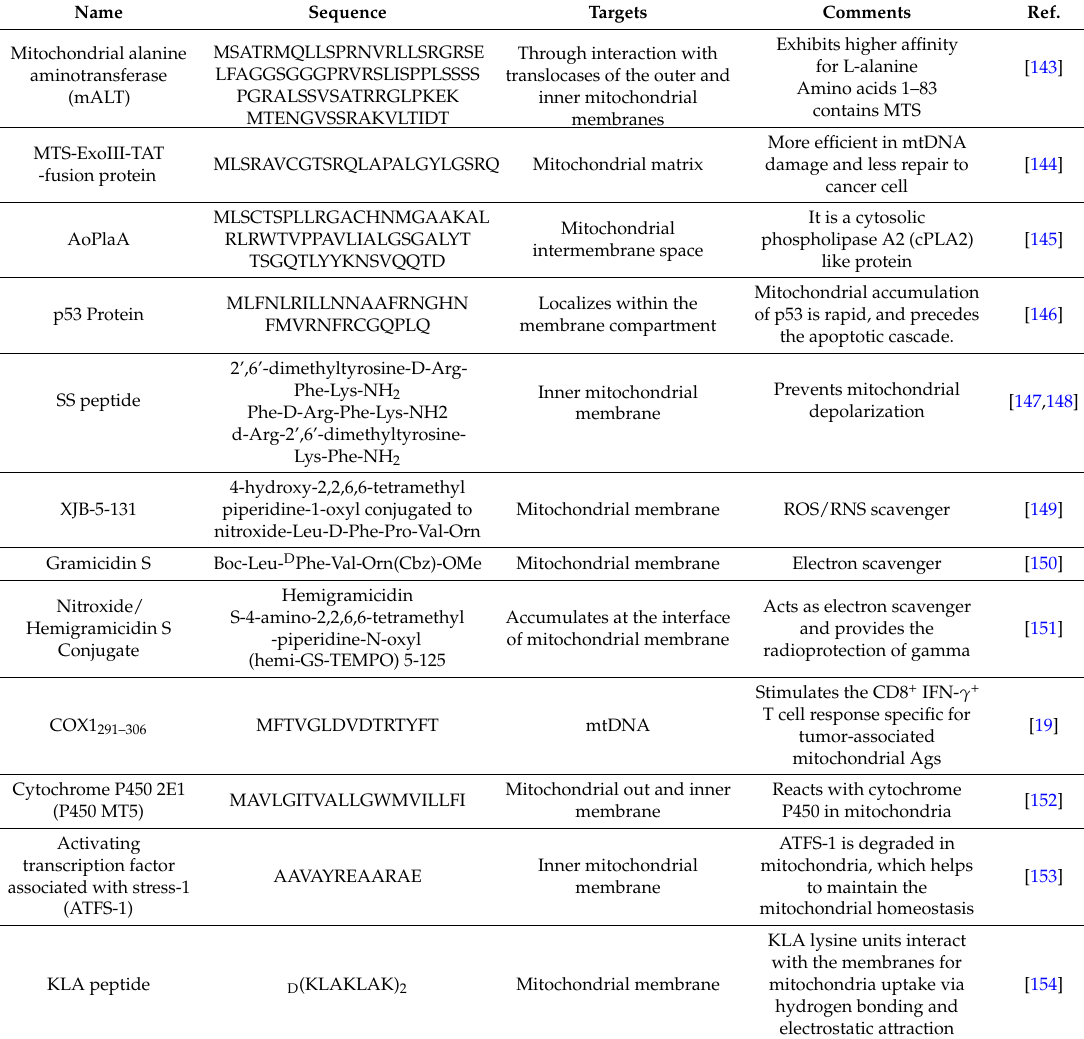
Table 6. Summary of peptides with a mitochondria targeting